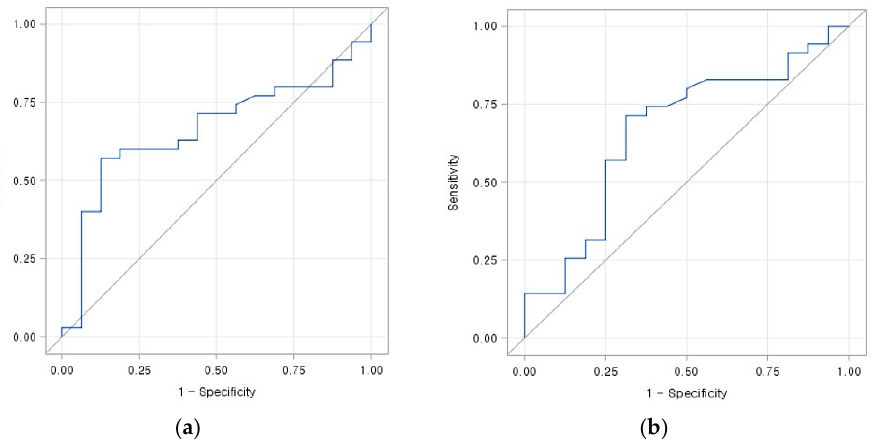
Figure 4. Receiver operating characteristic curve analysis of perfusion factors of foot to predict clinical success on cone-beam CT–based foot perfusion mapping obtained before and after percutaneous transluminal angioplasty for peripheral arterial disease. ( a ) Pre-PBV max of foot (area under curve = 0.663, cutoff value = 215, sensitivity = 57.1%, specificity = 87.5%). ( b ) Post-PBV max of foot (area under curve = 0.664, cutoff value = 235.7, sensitivity = 71.4%, specificity = 68.8%).